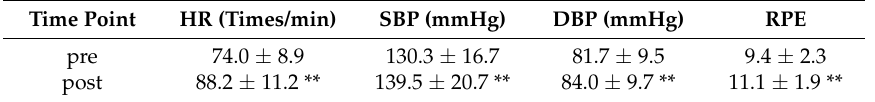
Table 2. HR, SBP, DBP, and RPE at pre and post six-minute walk test